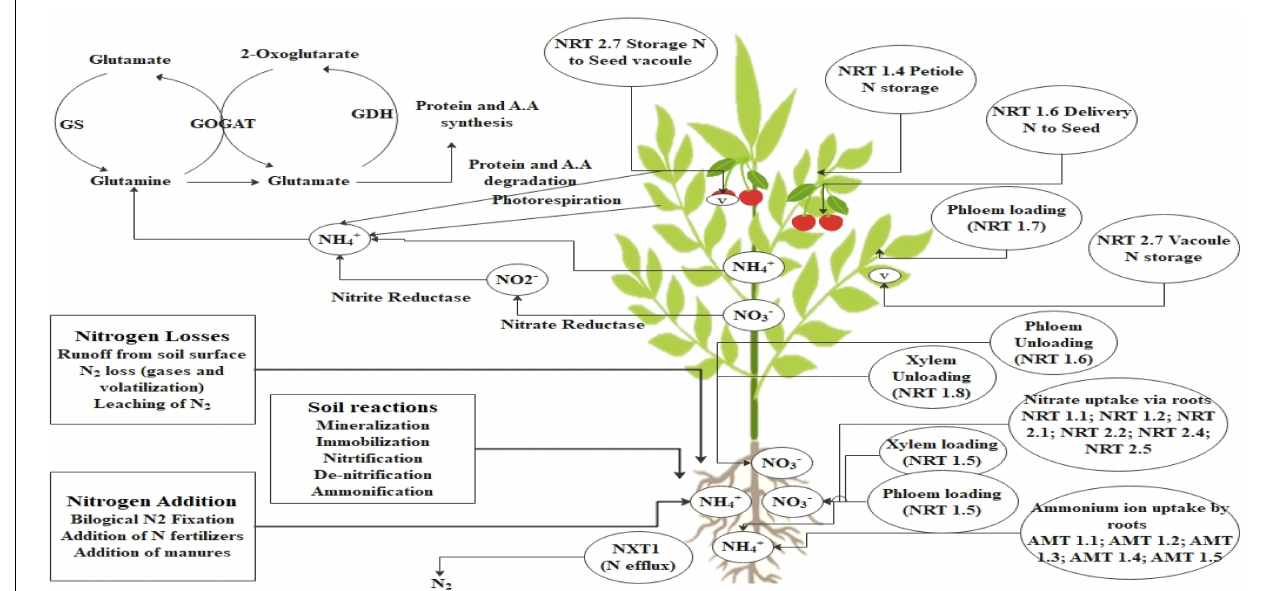
FIGURE 1 | N dynamic in plants. This figure represents the addition and losses of N through soil. There are several soil reactions such as mineralization, nitrification involved in the conversion of fixed N to available form and then uptake and transport from root to shoot. Nitrate (NRT; nitrate transporter) and ammonium (AMT; ammonium transporter) are the major forms of N movement through soil to root, root to root-shoot junction, then through phloem tissue. In this process, several transporters are involved which are highlighted in the figure such as phloem loading and unloading, xylem loading and unloading. After reaching the N in the leaf tissue is used for conversion of different compound synthesis and stored in the form of amino acids and proteins.